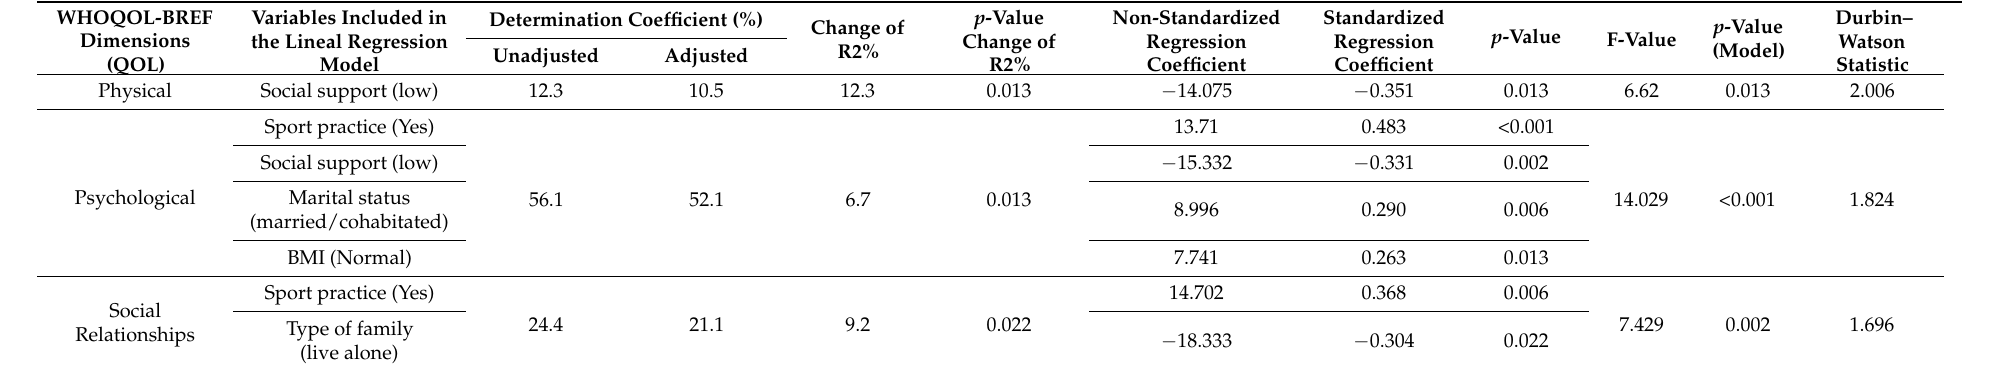
Table 3. Lineal regression models for the scores of the WHOQOL-BREF dimensions of QOL according to the variables included in the study sample ( n =